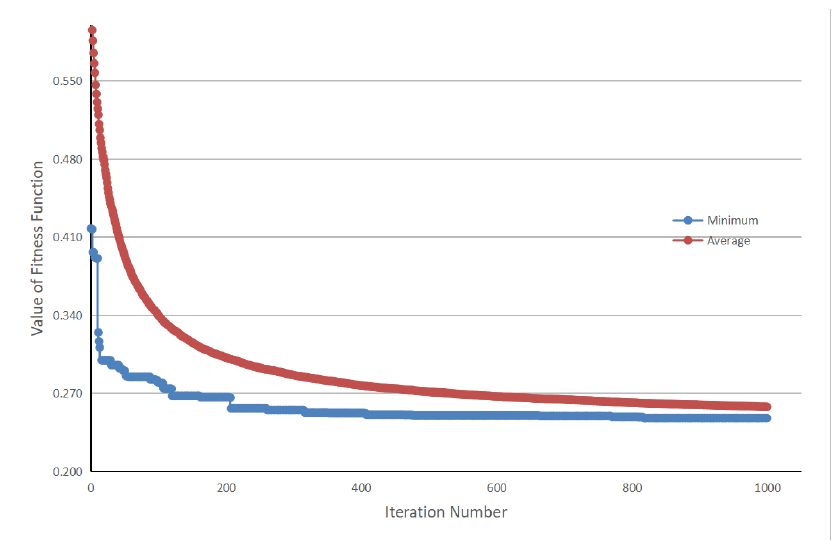
Figure 6. The relationship between average and minimum value of the fitness